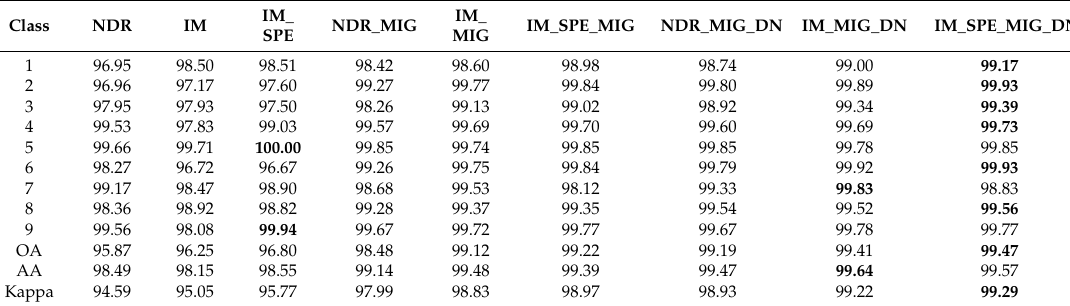
Table 4. The classification results on Pavia University